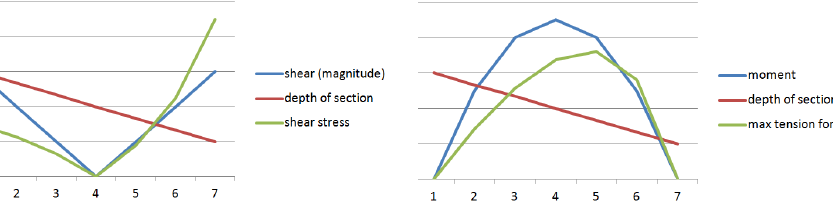
Figure 13: The magnitude of the shear in a beam varies linearly with x. With a reduction in the shear area the shear stress increases with x 2 .